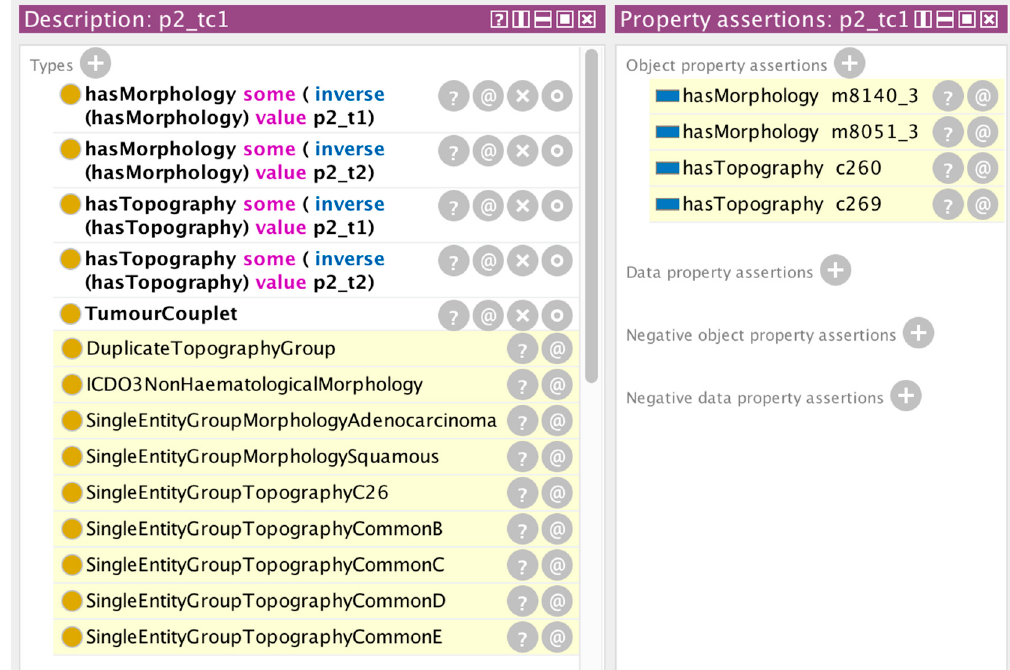
Figure 7. Results of the reasoning operation for the tumour couplet p2_tc1. Only the topography codes are equivalent and the couplet is a valid MPT.